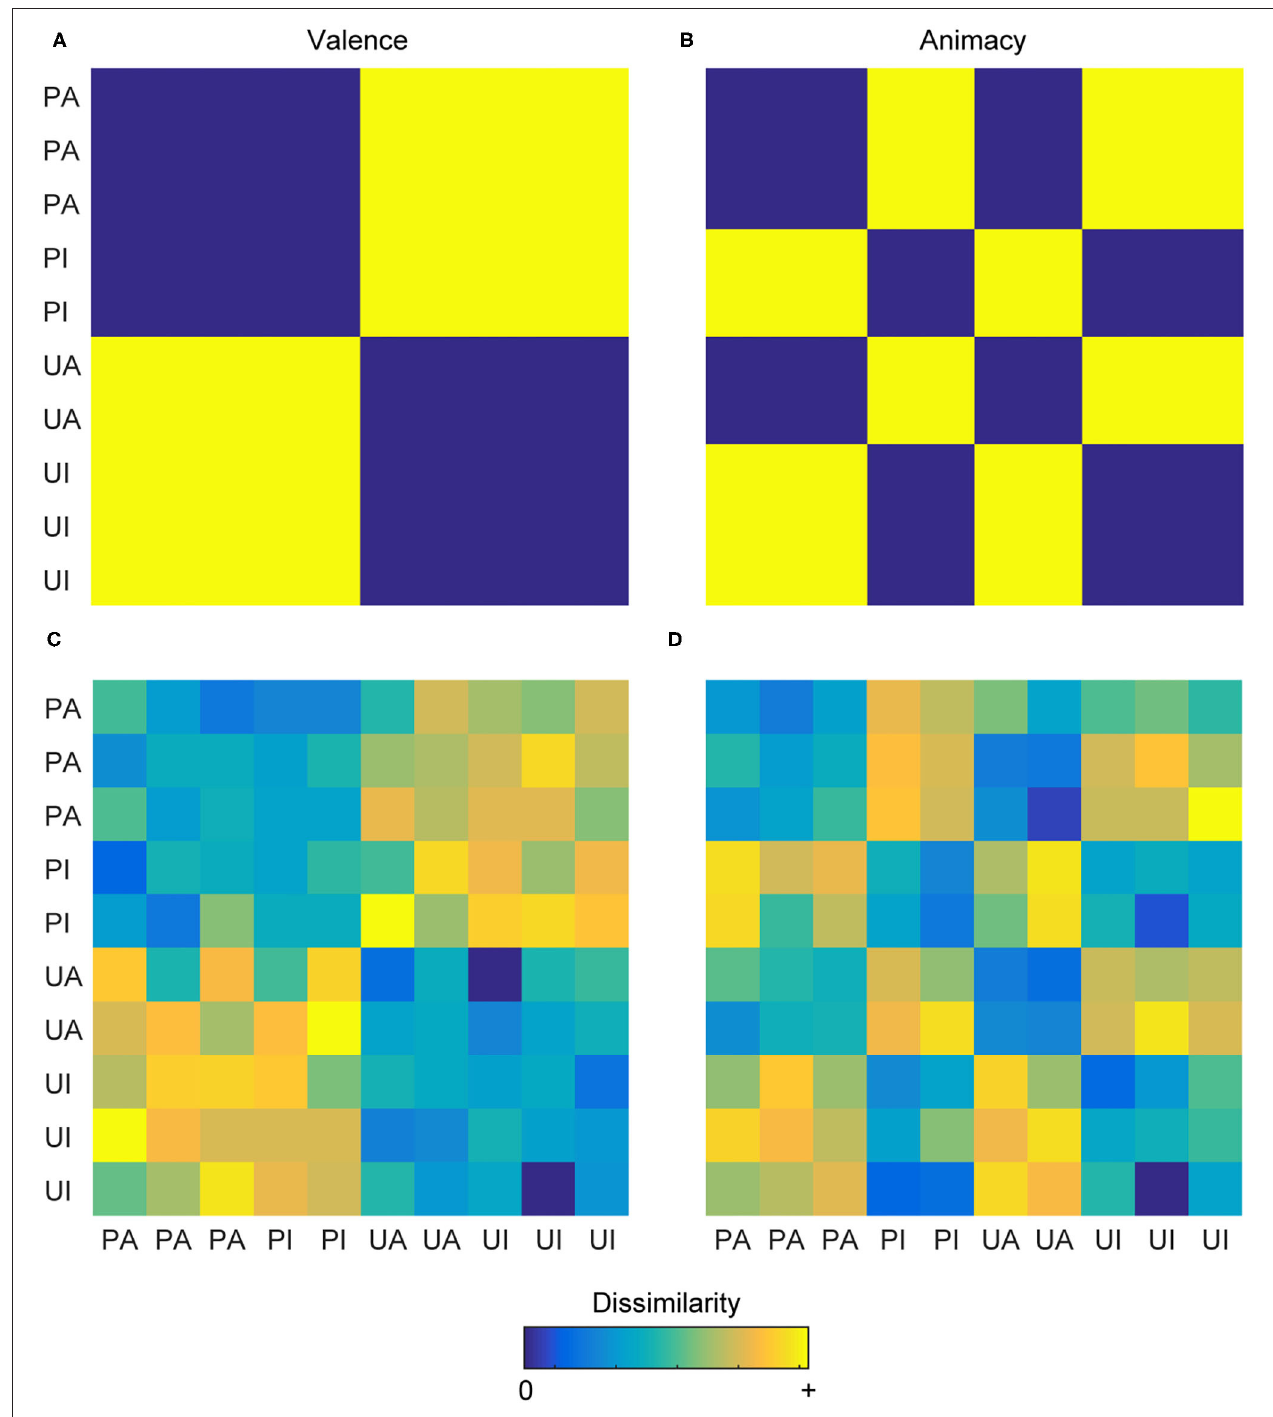
FIGURE 1 | Representational dissimilarity matrices. (A) A theoretical RDM depicting the binary relationship between pairs of images classified as pleasant-animate (PA), pleasant-inanimate (PI), unpleasant-animate (UA), and unpleasant-inanimate (UI) according to their valence. (B) A theoretical RDM depicting the binary relationship between these same images according to their animacy. These two models are effectively uncorrelated ( r = − 0.08) and can be used to explore the hypotheses of whether a particular brain region encodes valence information or animacy information. Cool colors depict decreasing dissimilarity, and warm colors depict increasing dissimilarity. (C,D) The same conventions as the upper row but depicted here are two RDMs that might result from a participant having carried out the multi-arrangement method, yielding a similar information structure as the theoretical RDMs but additionally containing graded, individualized information.